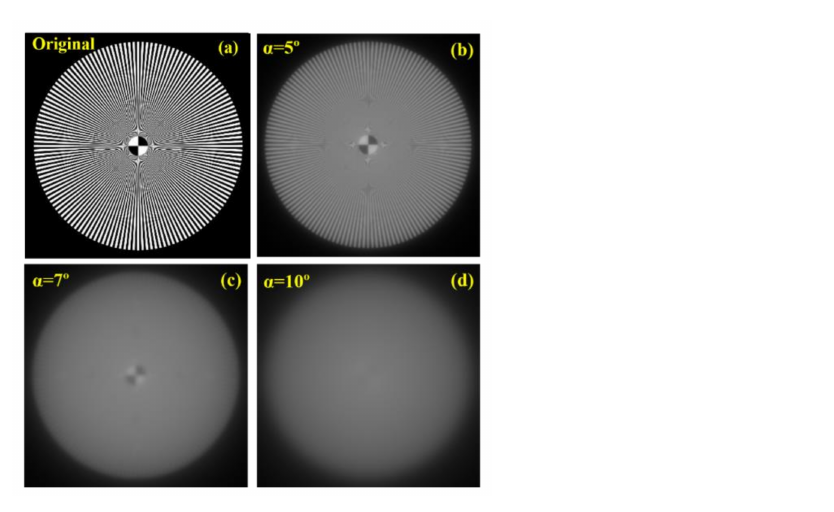
Figure 7. Theoretical eye model retinal images corresponding to different straylight angles. ( a ): Orig- inal; ( b ): α = 5º; ( c ): α = 7º; ( d ): α =